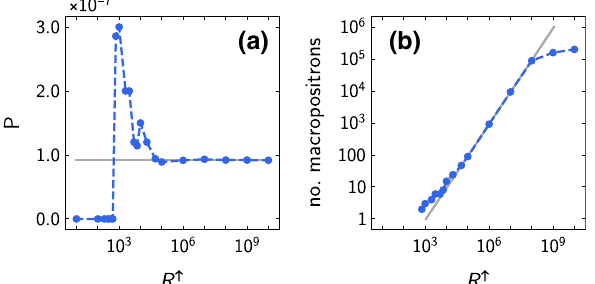
Fig. 2 a Pair creation probability and b number of macropositrons produced in Monte Carlo simulations of photons with energy param- eter η = 0 . 2 colliding with a laser pulse of amplitude ξ = 1 . 0 and duration N = 16, as a function of the rate increase R ↑ . The number of macrophotons and their individual weights are fixed at 10 4 and 10 − 4 , respectively. Grey solid lines indicate the expected results, a P (cid:17) 10 − 7 and b no. macroparticles = 10 4 P R